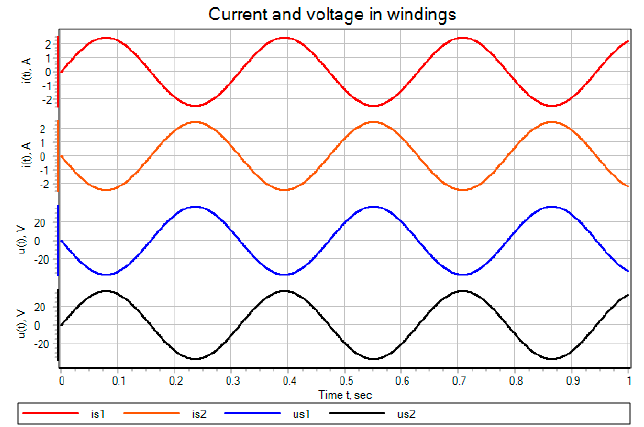
Figure 10. Generated current and voltage.